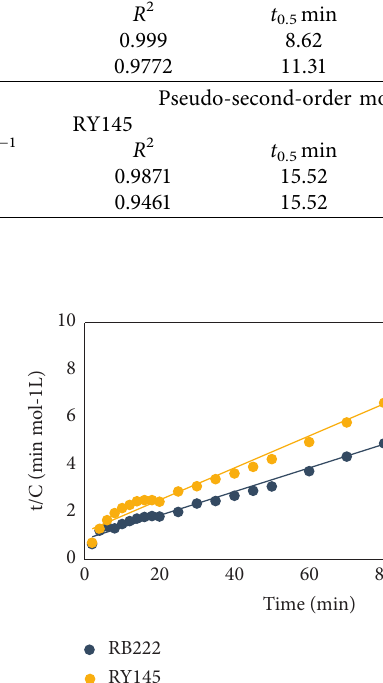
Table 2: Summarizing the constants of kinetics model and the correlation coefficients for RY145 and RB222 by SDS and CTAB surfactants. Surfactants